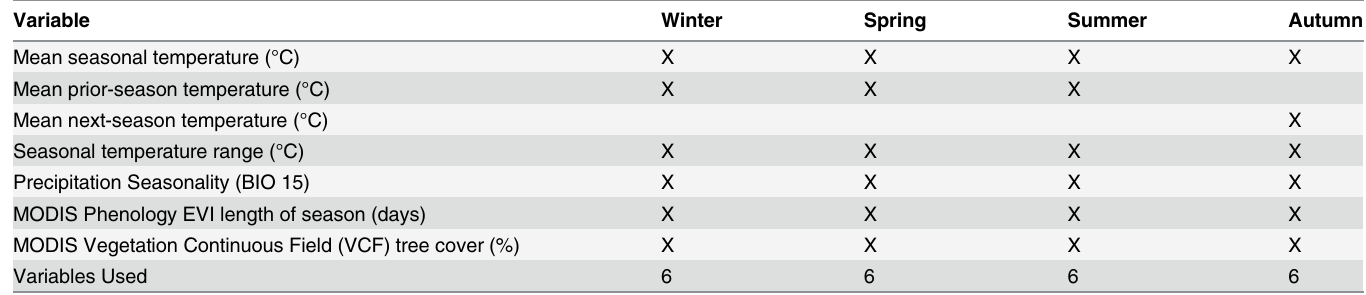
Table 1. Final set of predictor variables used in modeling patterns of season distribution of hoary bats ( Lasiurus cinereus ) in North America. Variable Winter Spring Summer